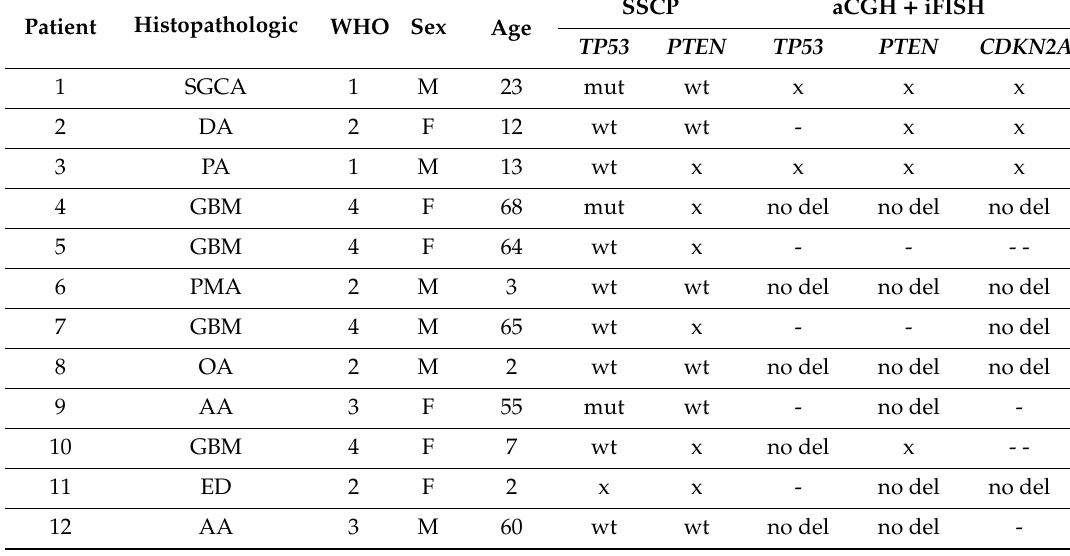
Table 7. Clinical data, molecular, and cytogenetic findings of patient’s samples used in the study. Patient